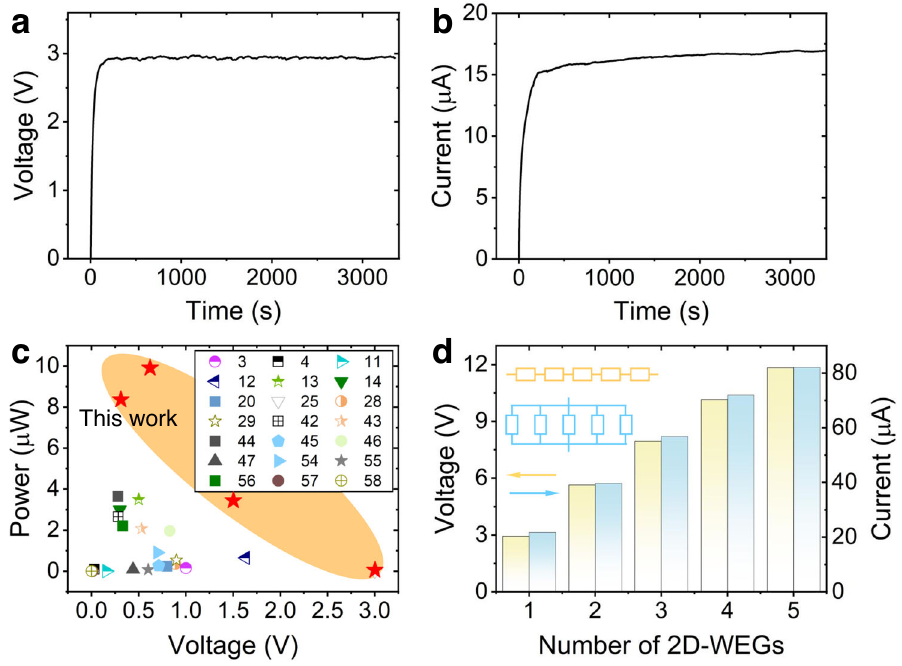
Fig. 6 | Electric output performance of optimized 2D-WEG. a The V oc output produced by a single 14.6cm length 2D-WEG designed by the opt-model. b The I sc output produced by a single 1cm length 2D-WEG. c Systematic performance comparison of V oc and power output of various reported spontaneous water fl ow-